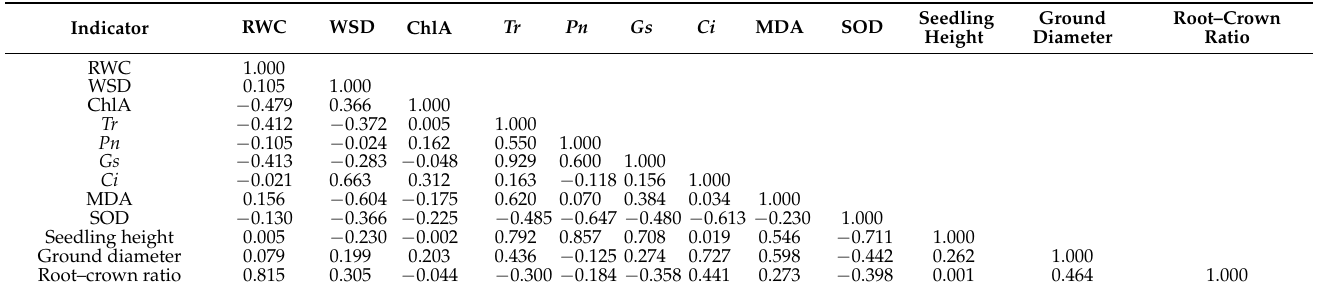
Table A4. Correlation analysis of the drought resistance coefficients of each index under moderate drought